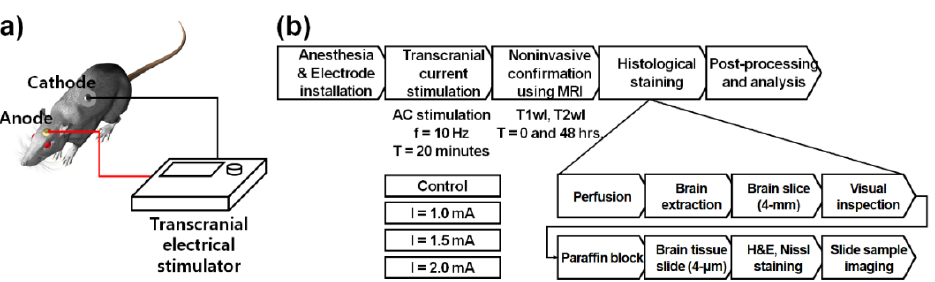
Figure 1. ( a ) Schematic of the installation of electrodes and the delivery of tACS. ( b ) Procedures for the safety assessment of